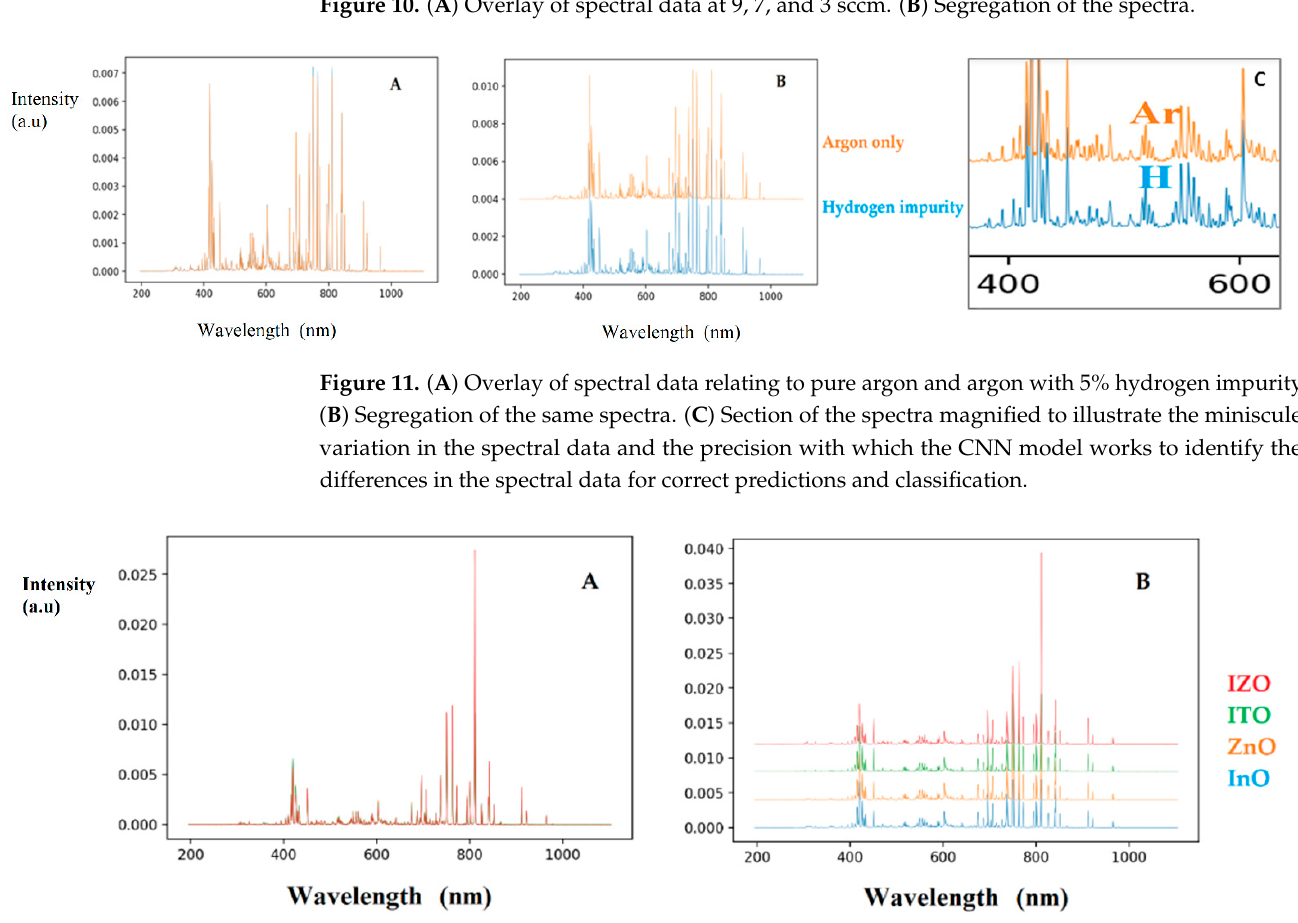
Figure 12. ( A ) Overlay of spectral data associated with four example target materials. ( B ) of the Segregation of the spectra.